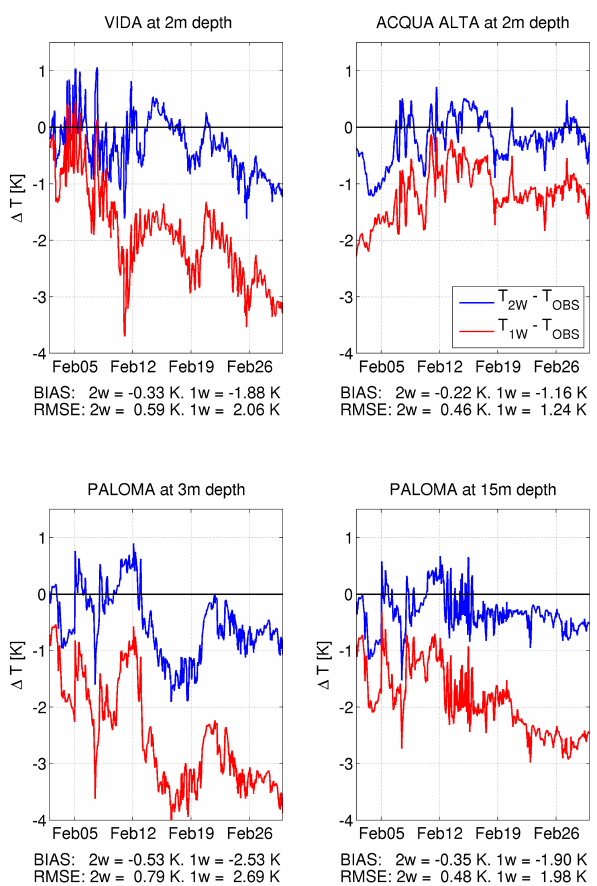
Figure 12. Differences, biases and RMSEs of modeled and ob- served temperatures at Vida, Paloma and Acqua Alta locations. Top left: sea temperature difference between observations and POM1w (red line) and POM2w (blue line) at Vida location. Top right: the same for Acqua Alta location. Bottom left: the same for Paloma lo- cation at 3m depth. Bottom right: the same for Paloma location at 15m depth. Respective biases and RMSEs are included below each